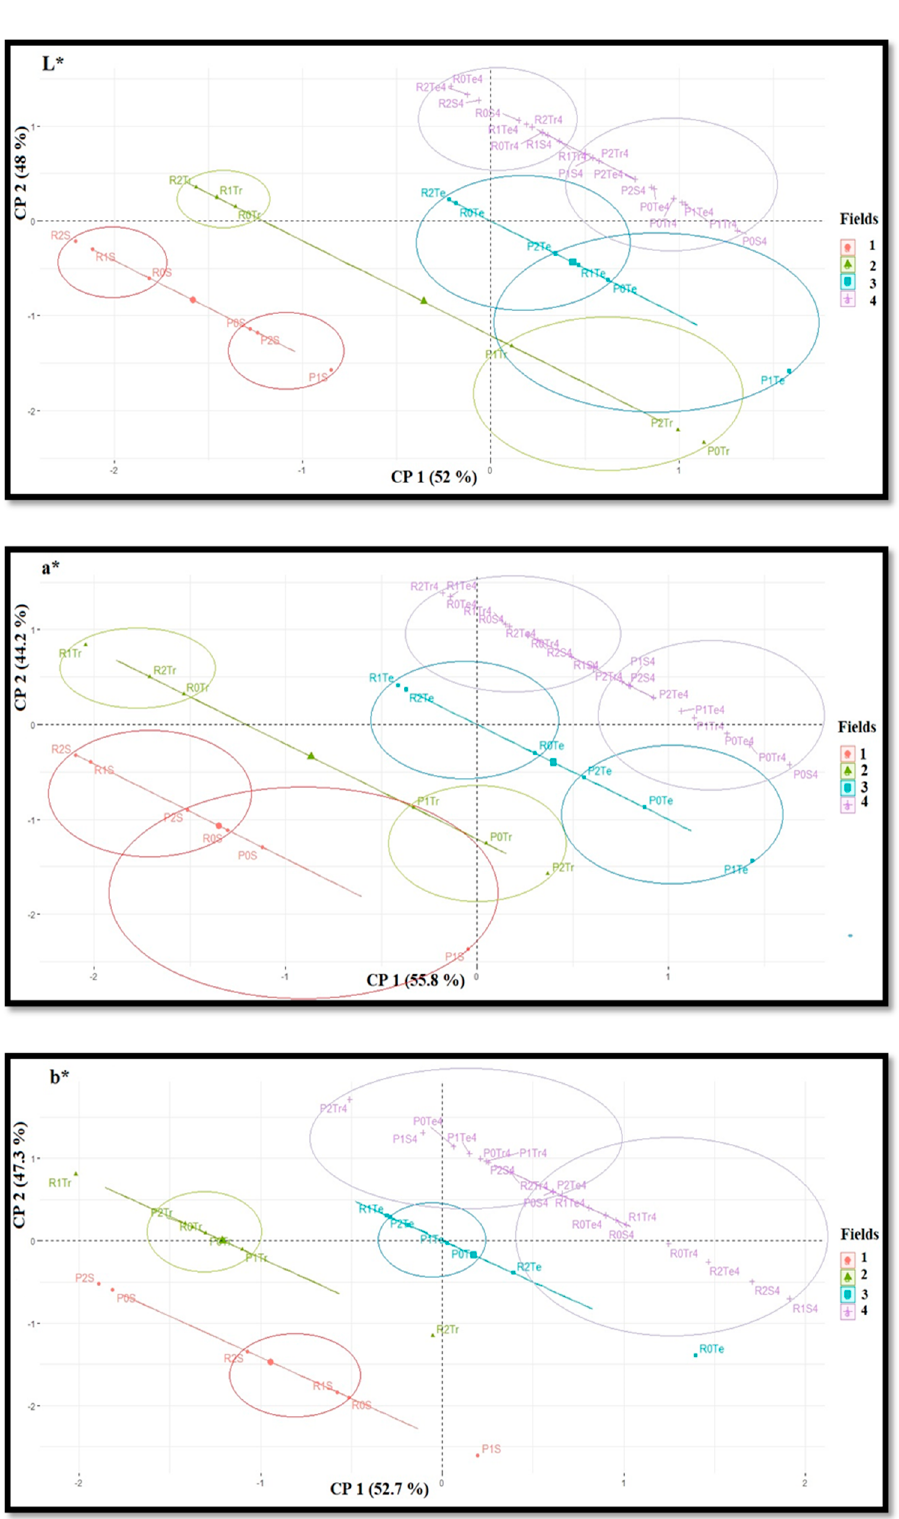
Figure 4. Attributes distribution formed by first and second principal components (CP 1 and CP 2, respectively) of colorimeter parameters L*, a* and b*—CIELab System ( n = 12) of whole wheat flour, of fields 1, 2, 3 and 4 of Triticum aestivum L., varieties Roxo (R) and Paiva (P). Concentrations of treatments from the same fertilizer are divided into: control (0); C1 (1), C2 (2) corresponding, respectively, to an initial application and the upper application of the fertilizers ZnSO 4 (S), Zn-EDTA (Tr) and Tecnifol Zinc (Te) (statistical analysis by software R version